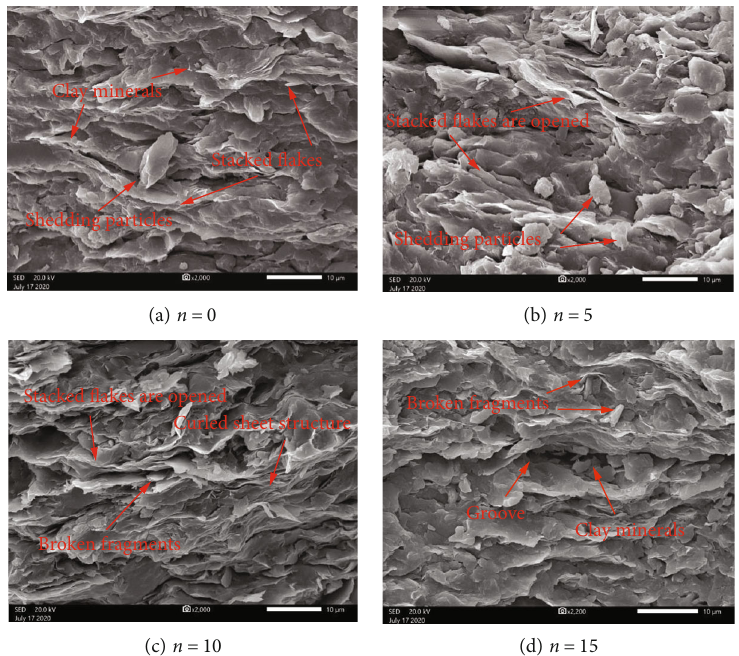
Figure 4: Scanning electron microscopy observation for carbonaceous mudstone in the vertical layered